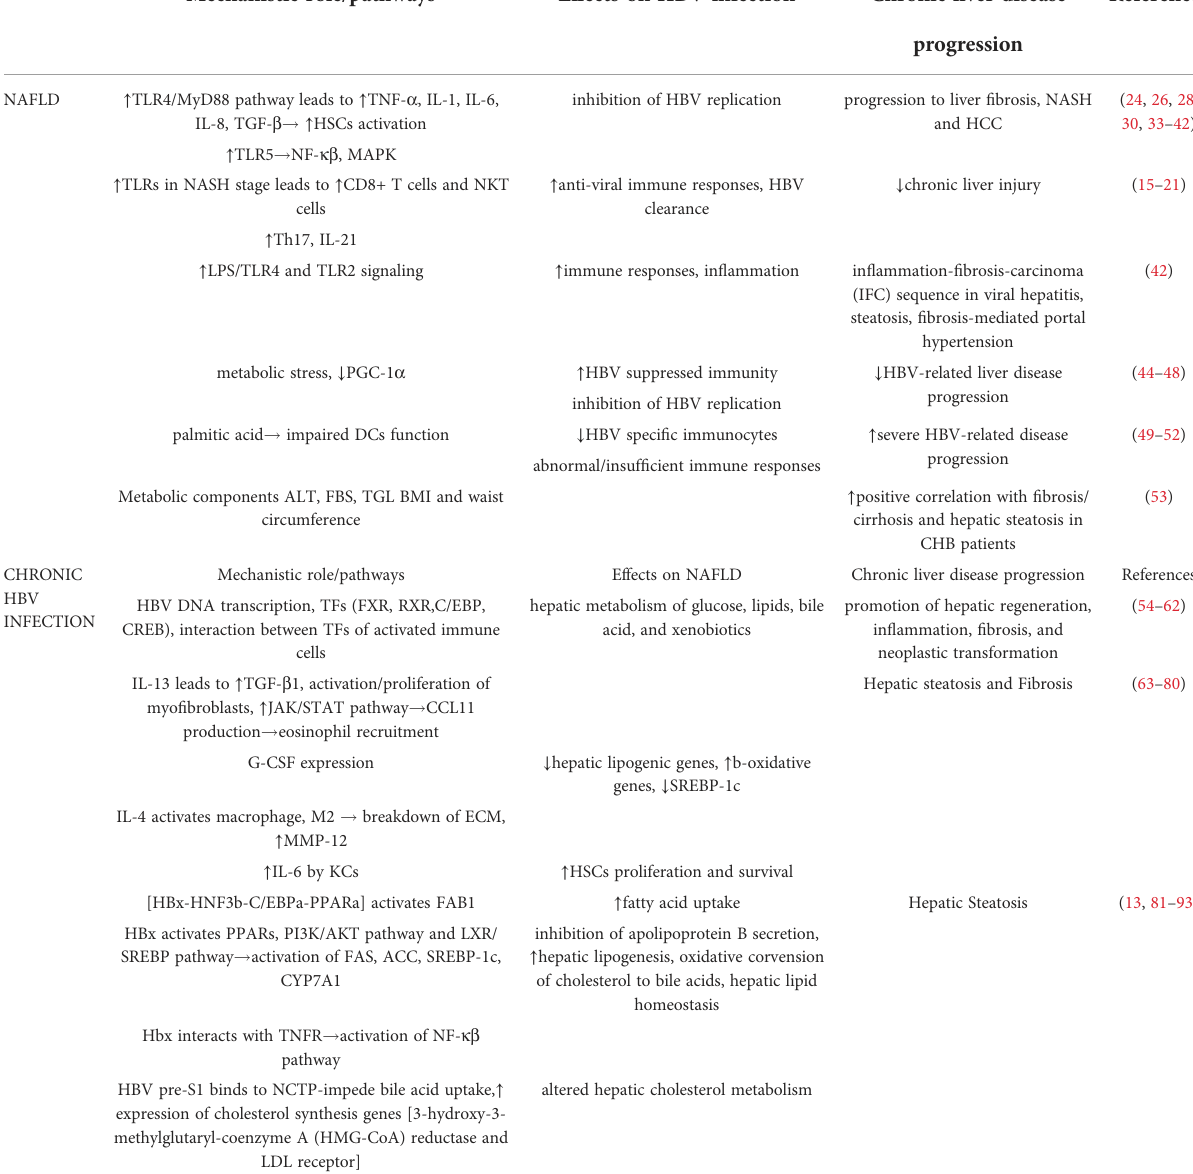
TABLE 1 Mechanistic role of NAFLD-HBV interplay in chronic liver disease progression. Mechanistic role/pathways Effects on HBV